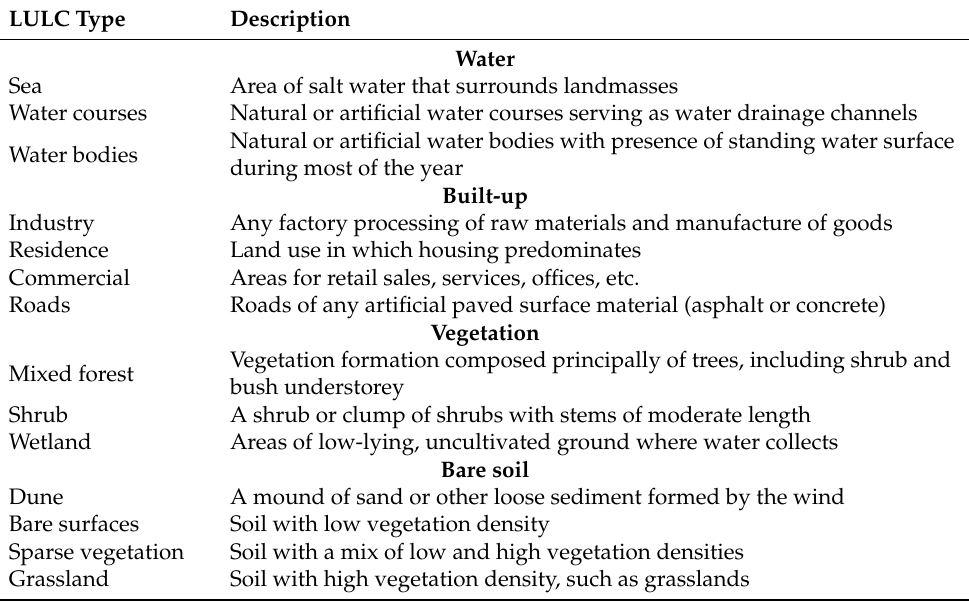
Table 3. Land use and land cover (LULC) classes and